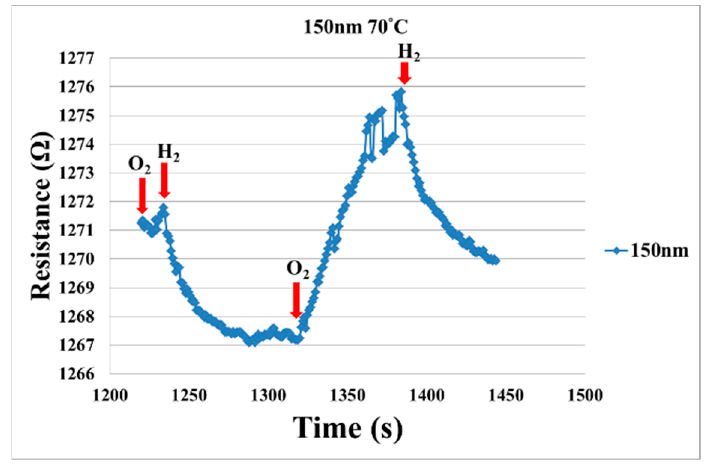
Figure 5. Resistance changes when oxygen and hydrogen are admitted into micro hydrogen sensor with SnO 2 in film thickness of 150 nm at 70 °C.